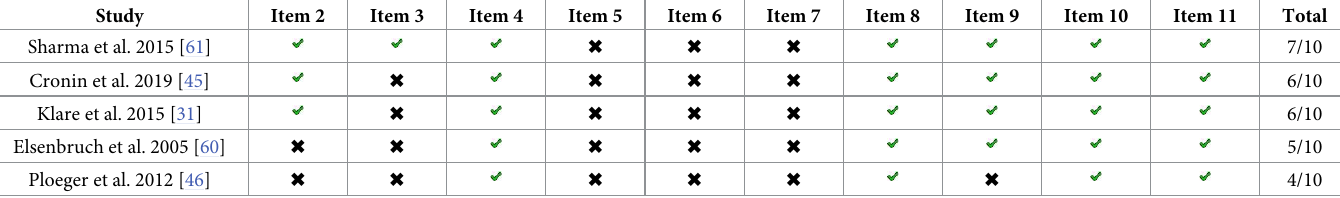
two independent data sets which were extracted separately. Fig 2A demonstrates a forest plot examining the overall effect of exercise on IL-6. When all outcomes were collated for each trial, data found no significant differences ( SMD = -0.09; 95% CI = -0.49, 0.30; P = 0.64). A similar trend for TNF- α was observed ( SMD = 0.08; 95% CI = -0.31, 0.48; P = 0.68; Fig 2B). No heterogeneity was displayed in IL-6, TNF- α , C-reactive protein (CRP), or IL-17 ( I 2 = 0%). Fur- ther, there was no effect of exercise on CRP ( SMD = -0.04; 95% CI = -0.58, 0.50; P = 0.89; Fig 3A). Ploeger et al. [46] was the only study to report on IL-17 and no significant overall effect of File displays a forest plot that presents the effect exercise has on leukocytes with no significant difference reported ( SMD = 0.40; 95% CI = -0.53, 1.33; P = 0.40) and a high heterogeneity ( I 2 = 84%). Similarly, there was no effect of exercise on lymphocytes ( SMD = 0.32; 95% CI = -0.33, Analysis was conducted on the inflammatory markers where two or more data sets were reported on, therefore, data extracted from Sharma et al. [61] was not utilised to complete the